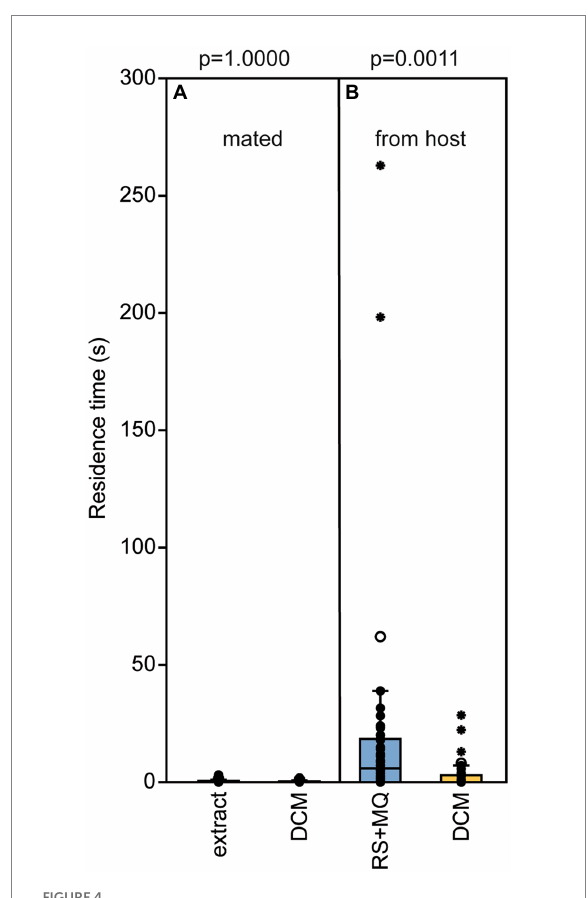
FIGURE 4 Newly emerged, but not mated, Nasonia longicornis females are attracted by the male pheromone. Residence time of N. longicornis females in the two odor fields of a static two-choice olfactometer when given the choice between dichloromethane (DCM, control) and (A) one male equivalent of a natural N. longicornis pheromone extract (mated females) or (B) a combination of synthetic (4 R ,5 S )-5-hydroxy-4-decanolide (RS) + 0.5 ng 4-methylquinazoline (MQ; females were collected during the process of emergening from the host). Box and whisker plots show median (horizontal line), 25%–75% quartiles (box), maximum/minimum range (whiskers) and outliers ( ° >1.5 × above box height; *>3 × above box height; n = 25, data analysis by a Wilcoxon matched-pairs